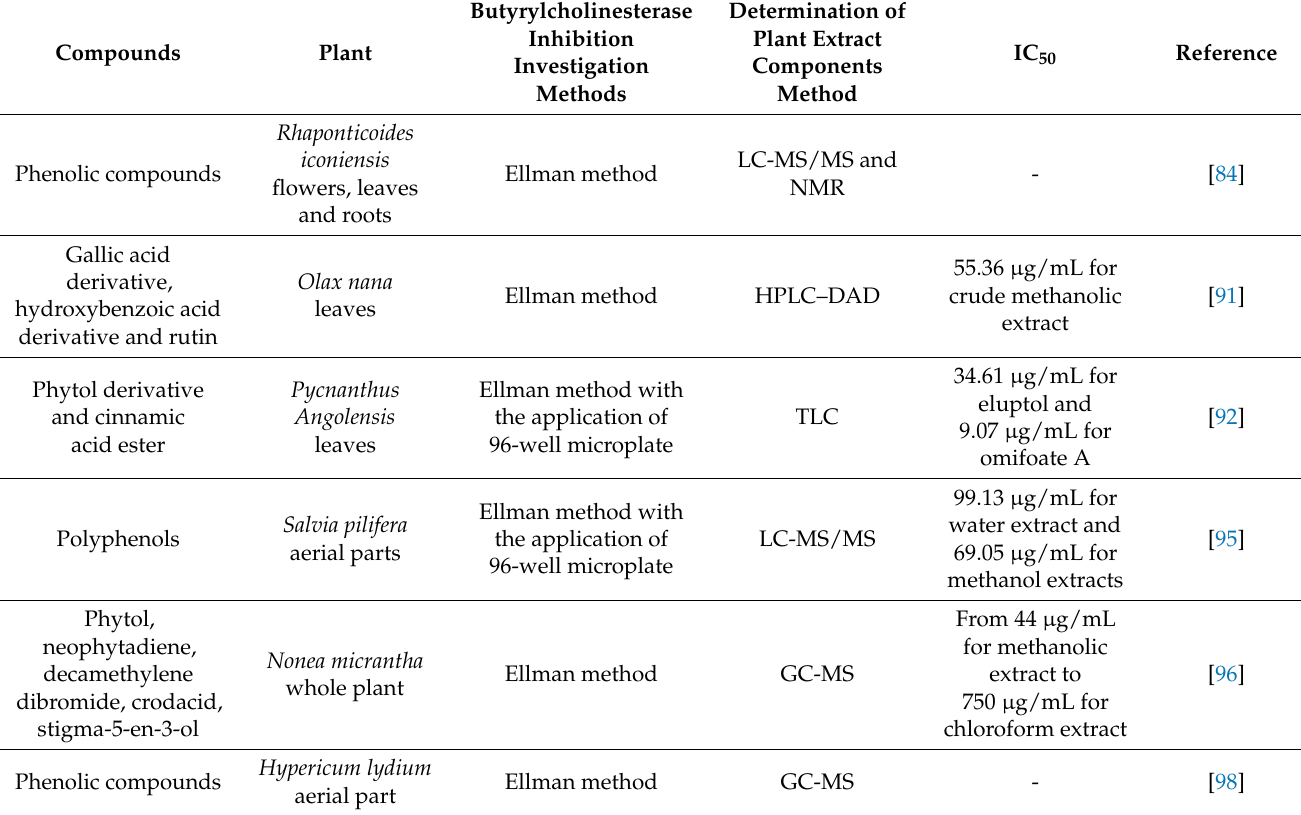
Table 2. Butyrylcholinesterase inhibition by plant